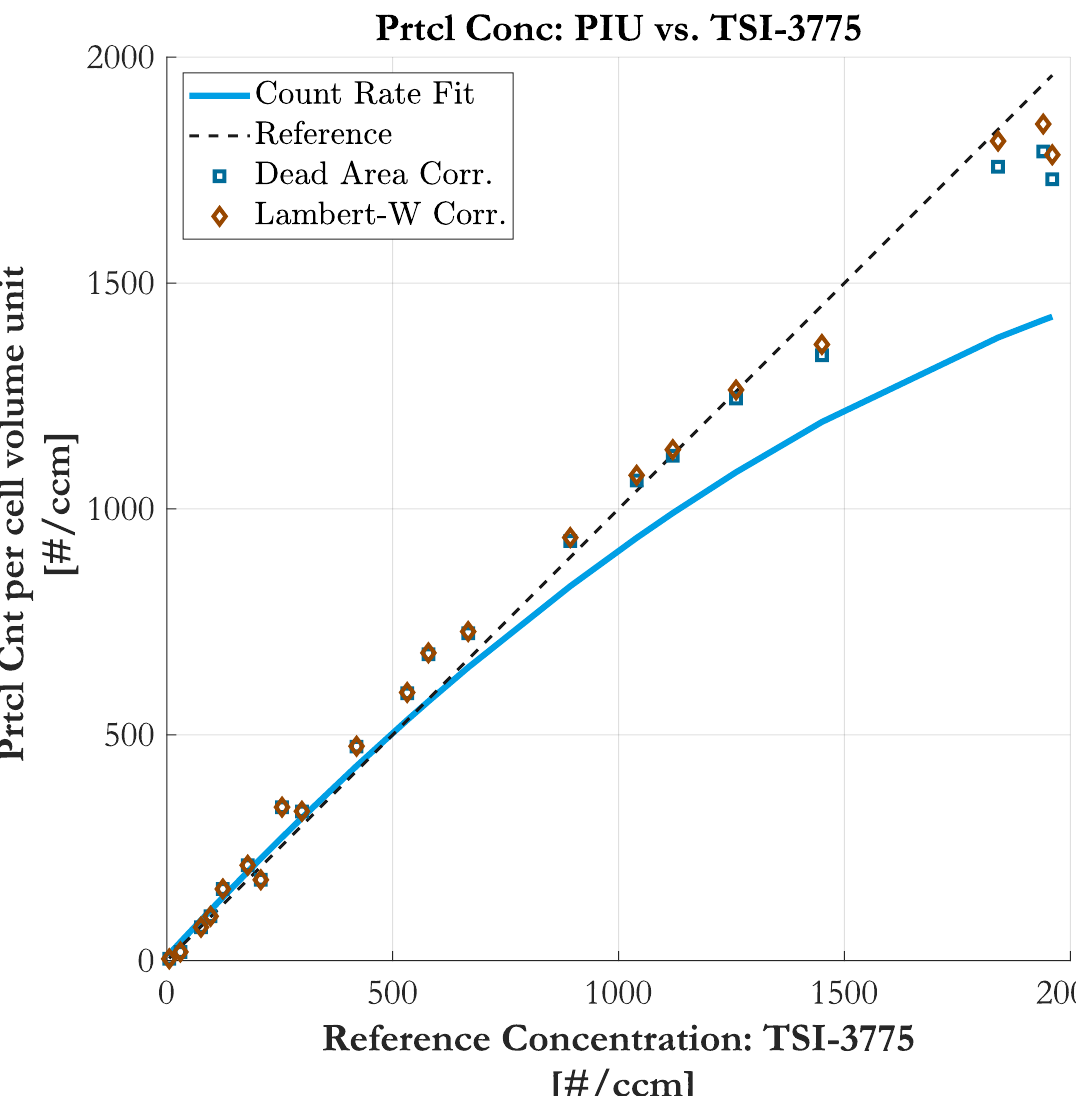
Figure 8. Comparison of particle number concentration obtained by the Particle Imaging Unit (PIU) and the TSI-3775 (uncorrected in blue). The concentration is coincidence-corrected by Dead Area and Lambert-W correction, both with a mean dead area diameter of δ d = 60